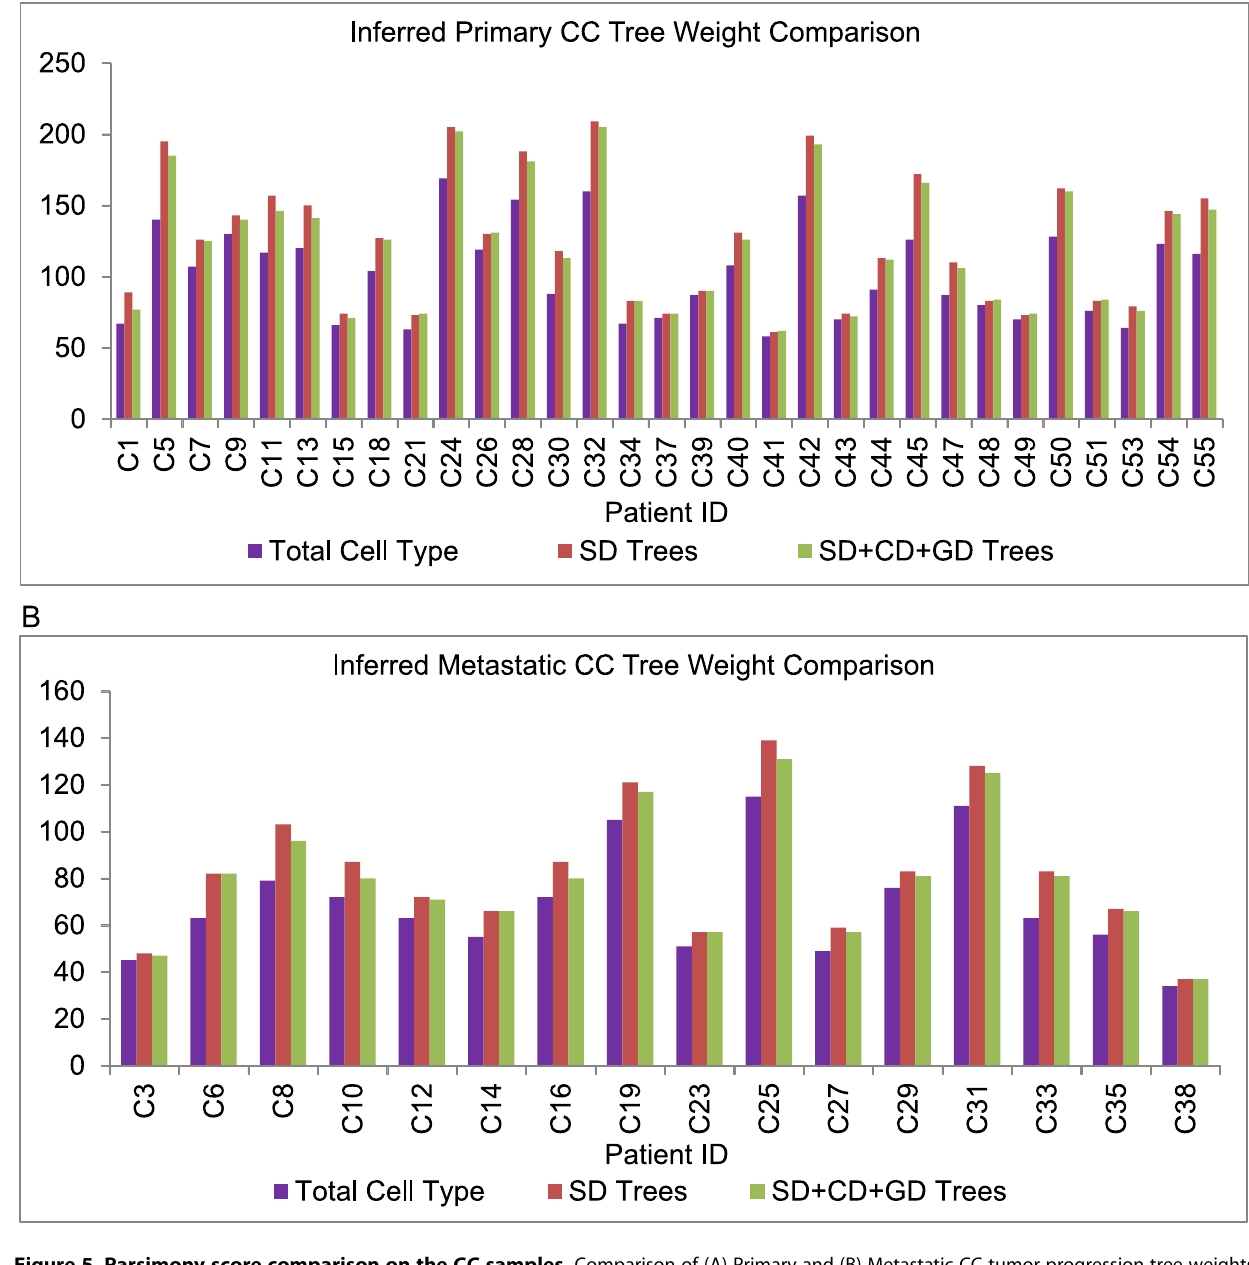
Figure 5. Parsimony score comparison on the CC samples. Comparison of (A) Primary and (B) Metastatic CC tumor progression tree weights built considering only SD and combined SD, CD and GD models. ‘‘Total Cell Type’’ refers to the total number of unique probe copy number configurations in the dataset, providing a lower bound on the minimum possible parsimony score for a given data set.